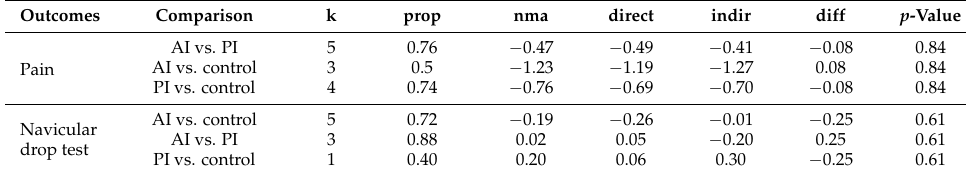
Table 6. The evidences of each comparison for pain and navicular drop.